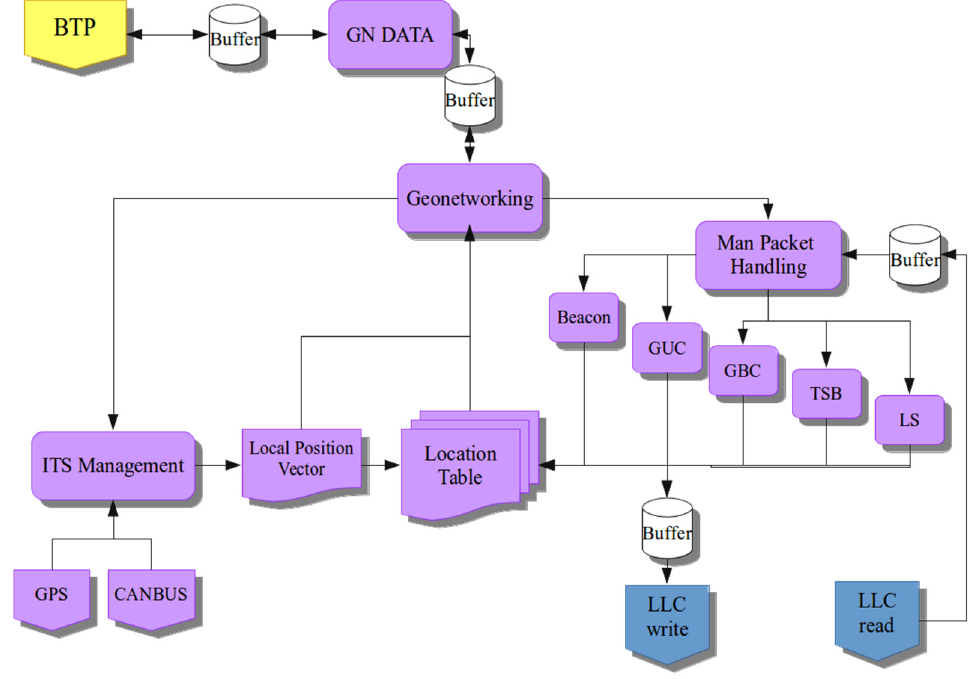
Figure 3. Software diagram. GeoUnicast (GUC), GeoBroadcast (GBC), Topology Scope Broadcast (TSB), or Location Service (LS).